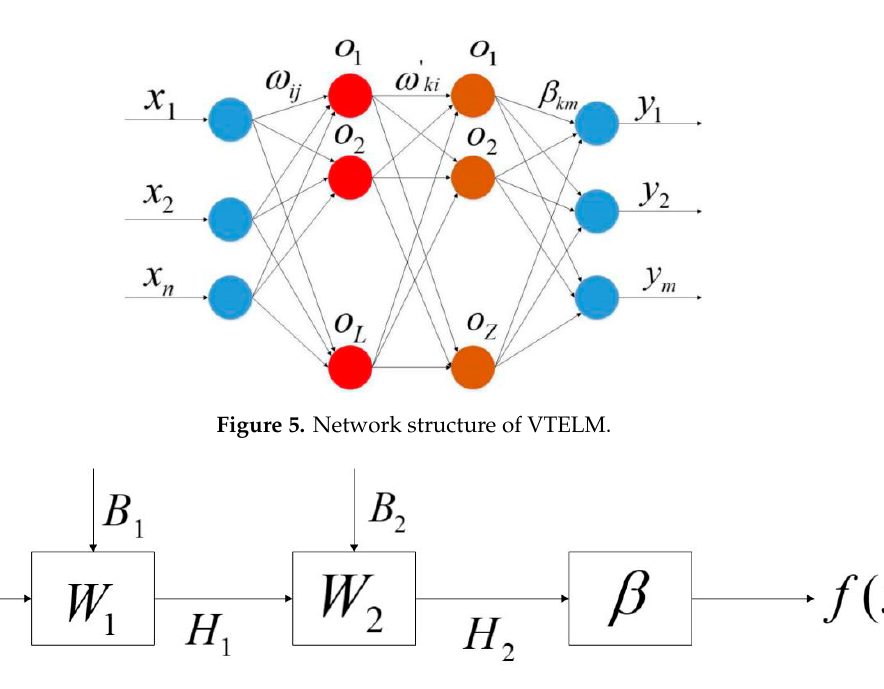
Figure 6. The work flow of the VTELM.